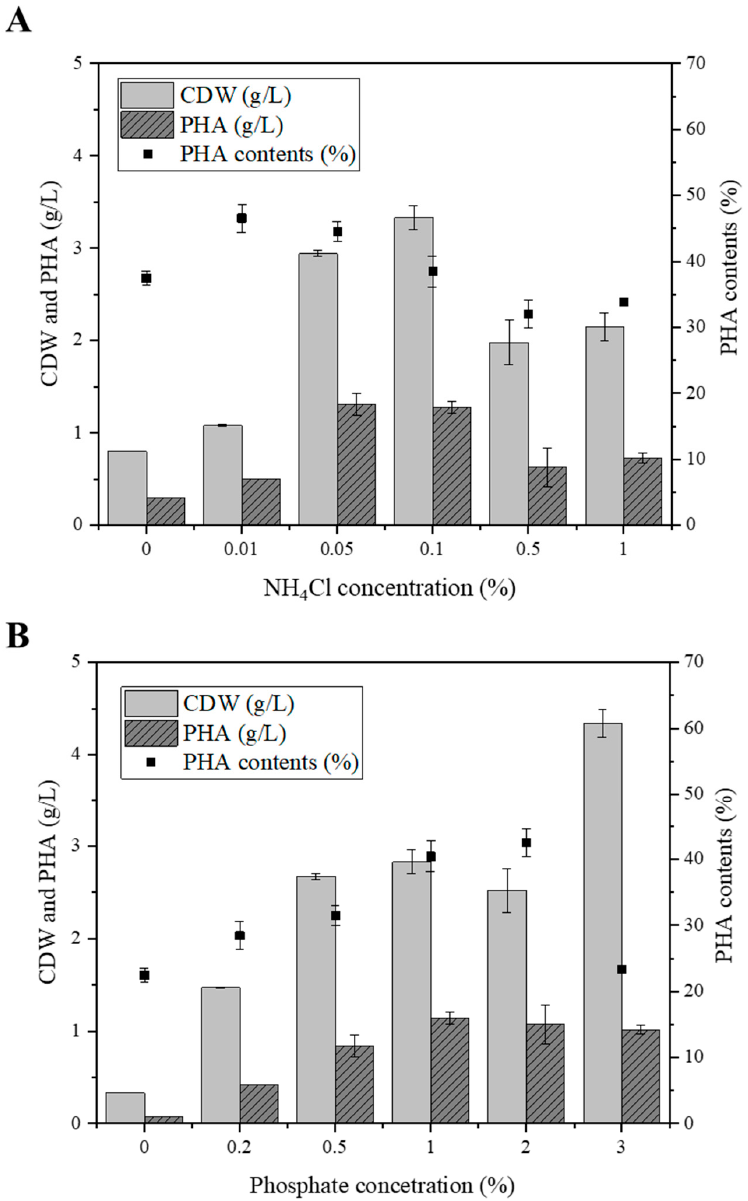
Figure 4. Effects of nitrogen and phosphorus limitation on PHA production. ( A ): CDW, PHA titer, and PHA content (%) in range of 0 to 1% nitrogen concentration. ( B ): CDW, PHA titer, and PHA content (%) in range of 0 to 3% phosphate concentration.